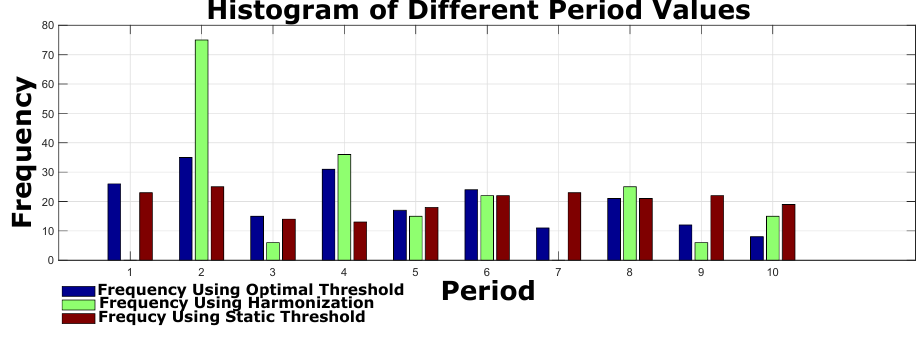
Figure 12. Histogram of different values of